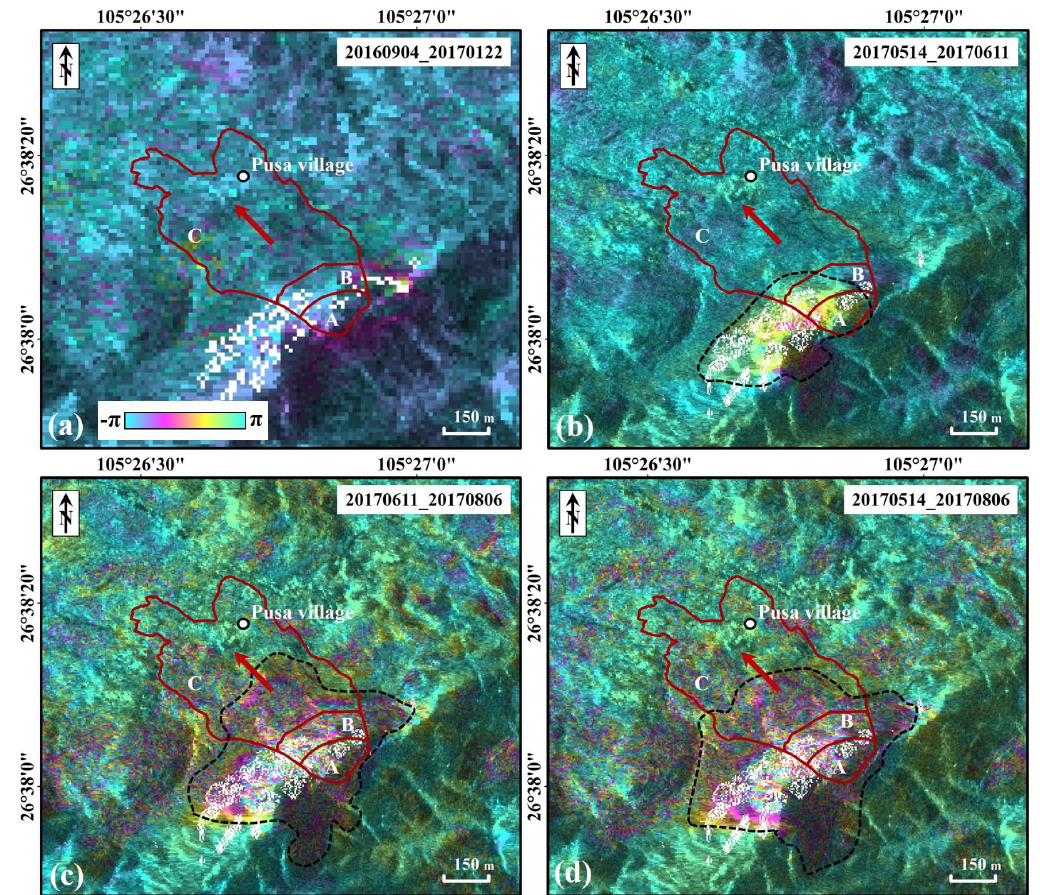
Figure 7. Pre-event geocoded differential interferograms generated by ALOS/PALSAR-2 datasets. ( a ) The interferogram calculated by SM3 mode ALOS/PALSAR-2 data acquired on 4 September 2016 and 22 January 2017. ( b–d ) The interferograms calculated by SM1 mode ALOS/PALSAR-2 data, ( b ) 14 May 2017 vs. 11 June 2017, ( c ) 11 June 2017 vs. 6 August 2017, ( d ) 14 May 2017 vs. 6 August 2017. The red line indicates the landslide boundary, the black dash line indicates the deformation region.